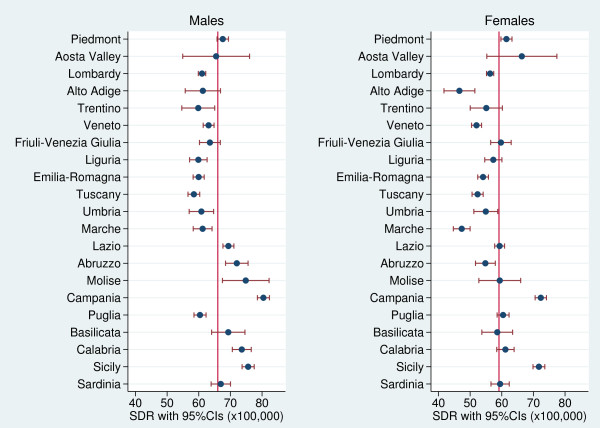
Forest plots showing the regional SDRs (with 95% CIs) by gender in relation to the Italian average (red line) for the years 2006–08.